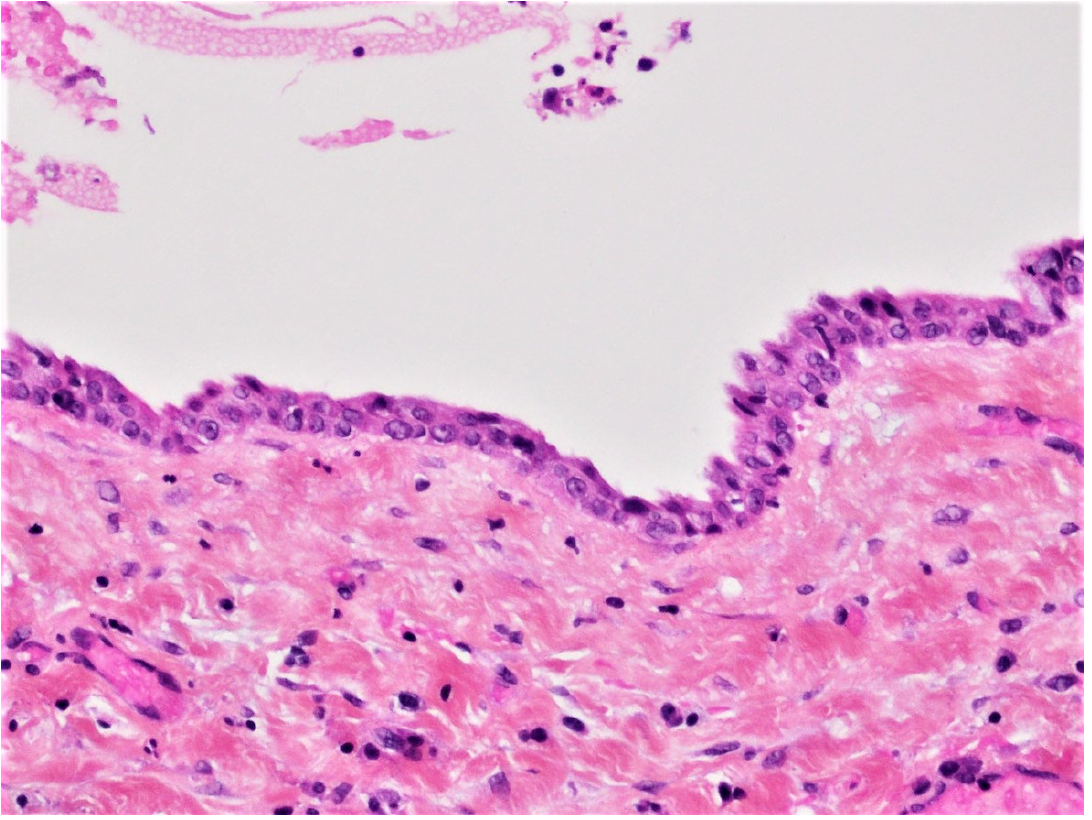
Figure 3. Histopathological examination of the enucleated specimen from case #1 showing an uninflamed fibrous cyst wall lined by a thin cuboidal epithelial lining (H&E, ×40).